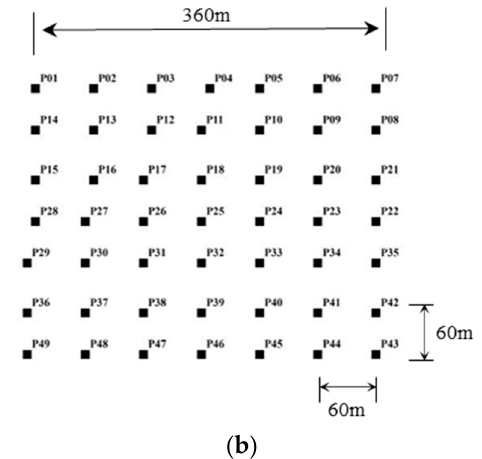
Figure 1. Land cover map of the study site and distribution of sampling point: ( a ) land cover map of the study site; ( b ) distribution of sampling point (P ii represents sampling point number).